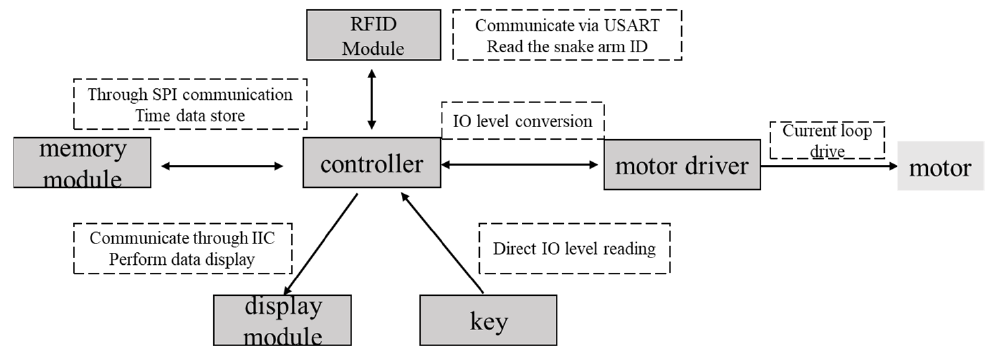
Figure 8. The presented configuration of the control system.